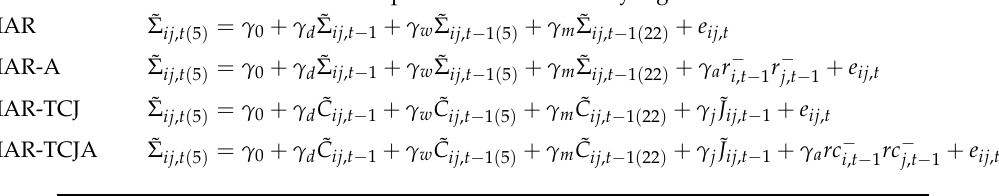
Table 5. In-sample estimates for weekly regressions.